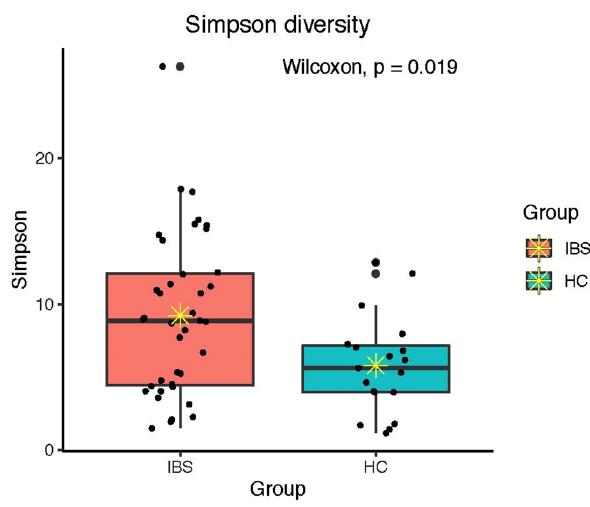
Figure 3. Simpson diversity between IBS and HC; * indicates